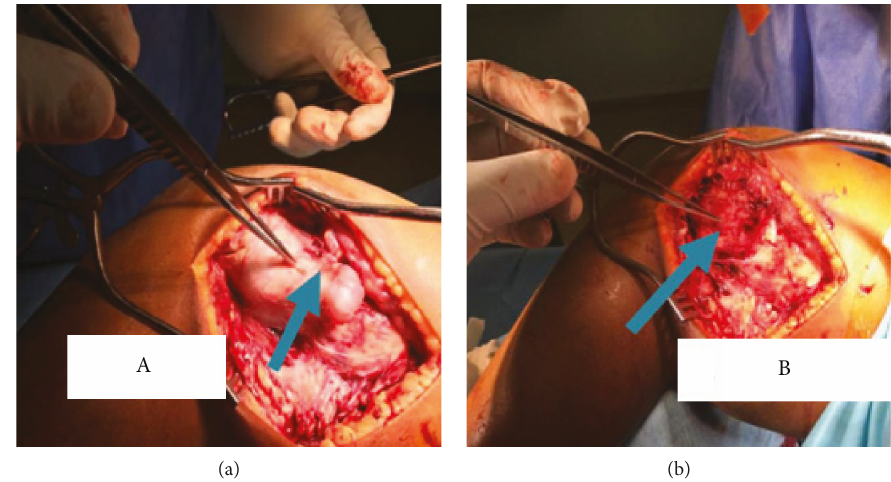
Figure 3: Photograph showing the (a) exostosis and (b) after excision of the exostosis of the left distal femur (see thick blue